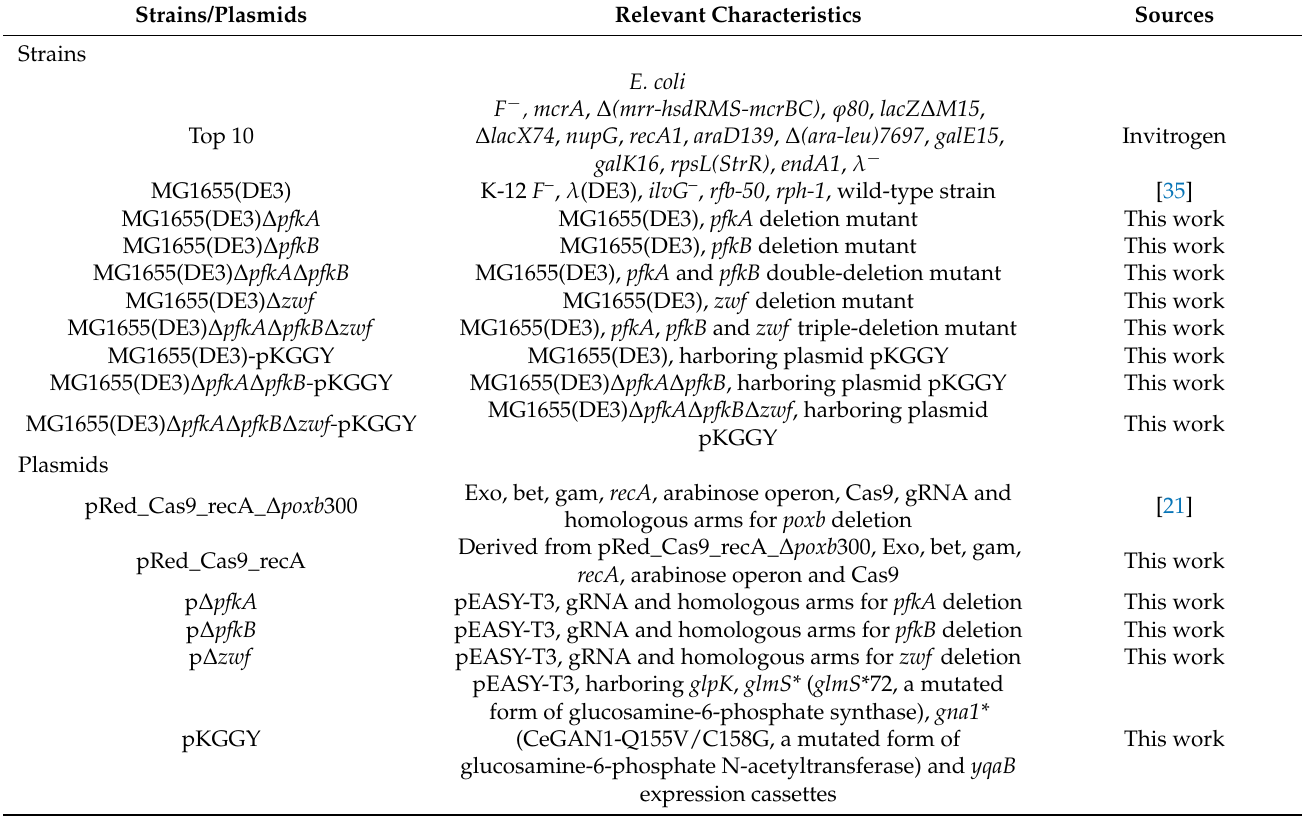
Table 1. Bacterial strains and plasmids used in this